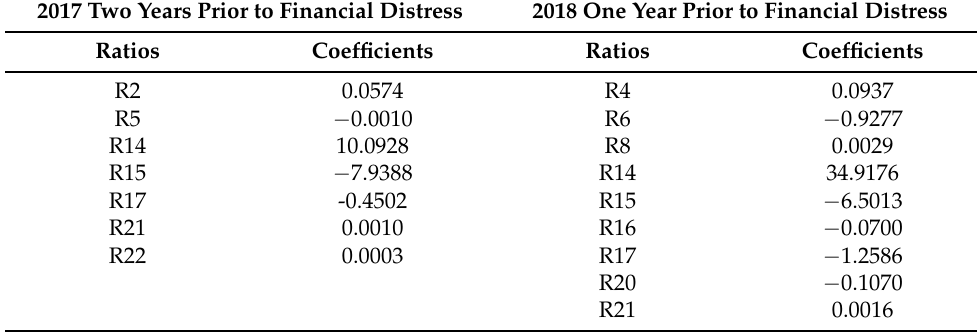
Table 6. Lasso logistic regression results.